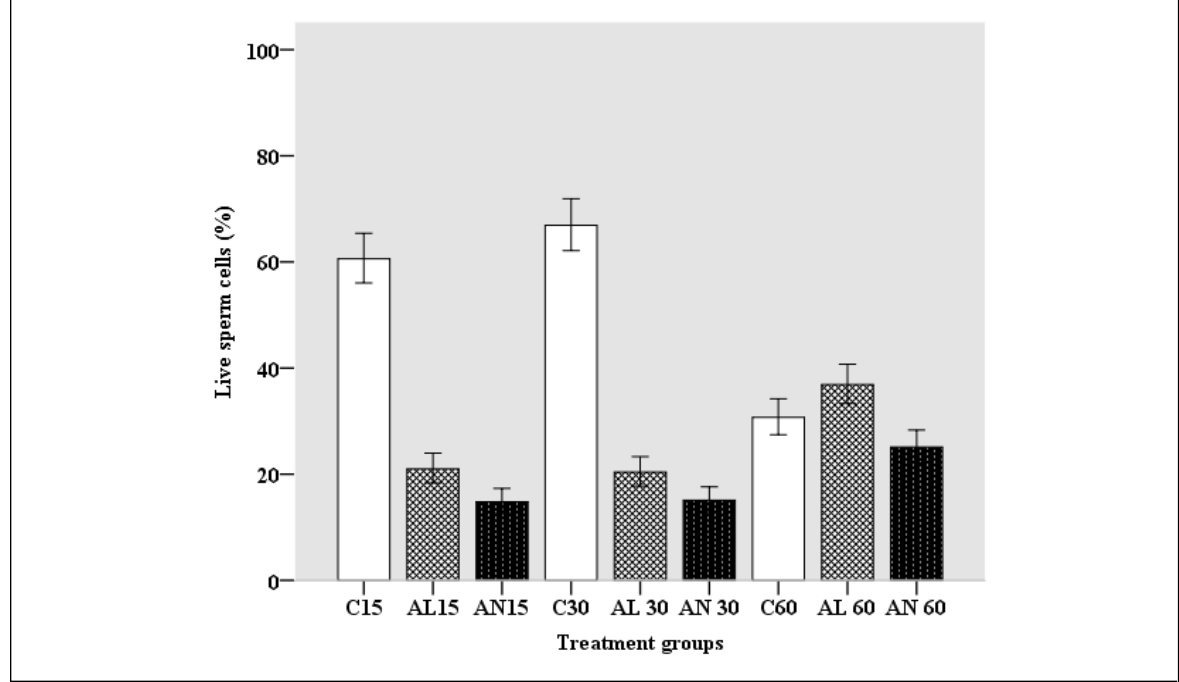
Figure 3: Effect of crude plant extract in feed on the percentage of live sperm cells following its treatment for 15, 30 or 60 days in the M. natalensis male rats. C = control groups, AL= A. lebbeck stem bark methanolic extract, AN = A. nilotica pods methanolic extract. Pearson chi-squared test: relation between sperm cell viability (%) against the treatment groups (  2 = 883.31, df = 2, p < 0.001) and treatment duration (  2 = 41.49, df = 2, p < 0.001)